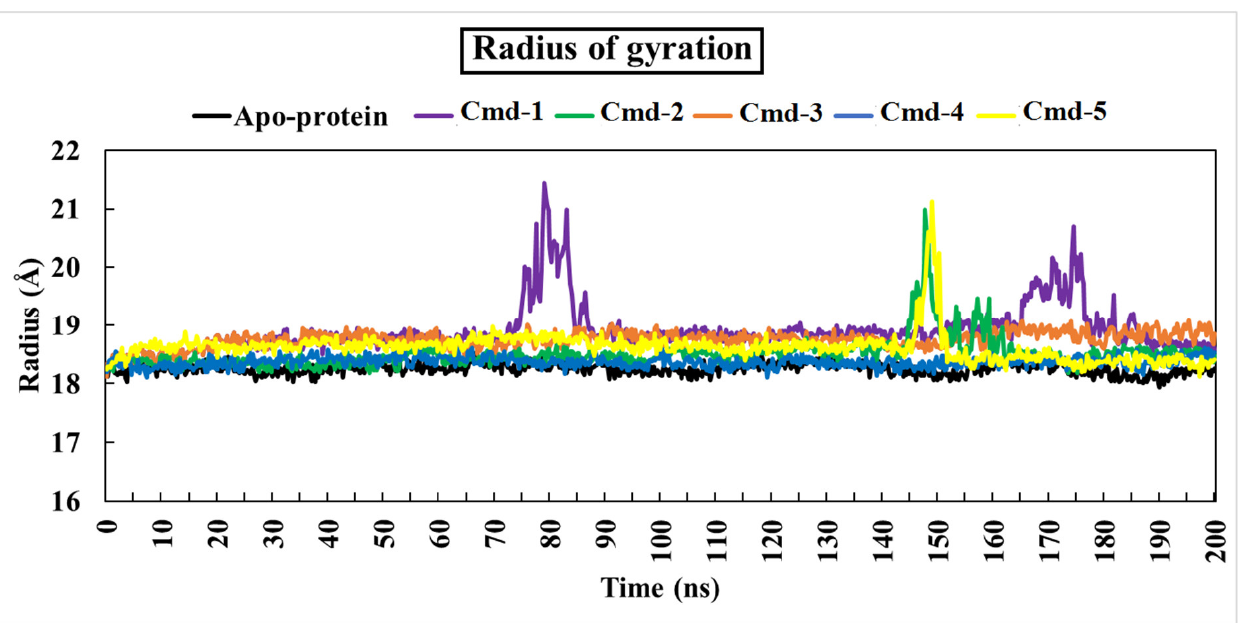
Figure 7. Root-mean-square-fluctuation (RMSF) of the apoprotein structure and five selected com- plexes (Omicron BA.1/Cmd-1, Omicron BA.1/Cmd-2, Omicron BA.1/Cmd-3, Omicron BA.1/Cmd-4, Omicron BA.1/Cmd-5).